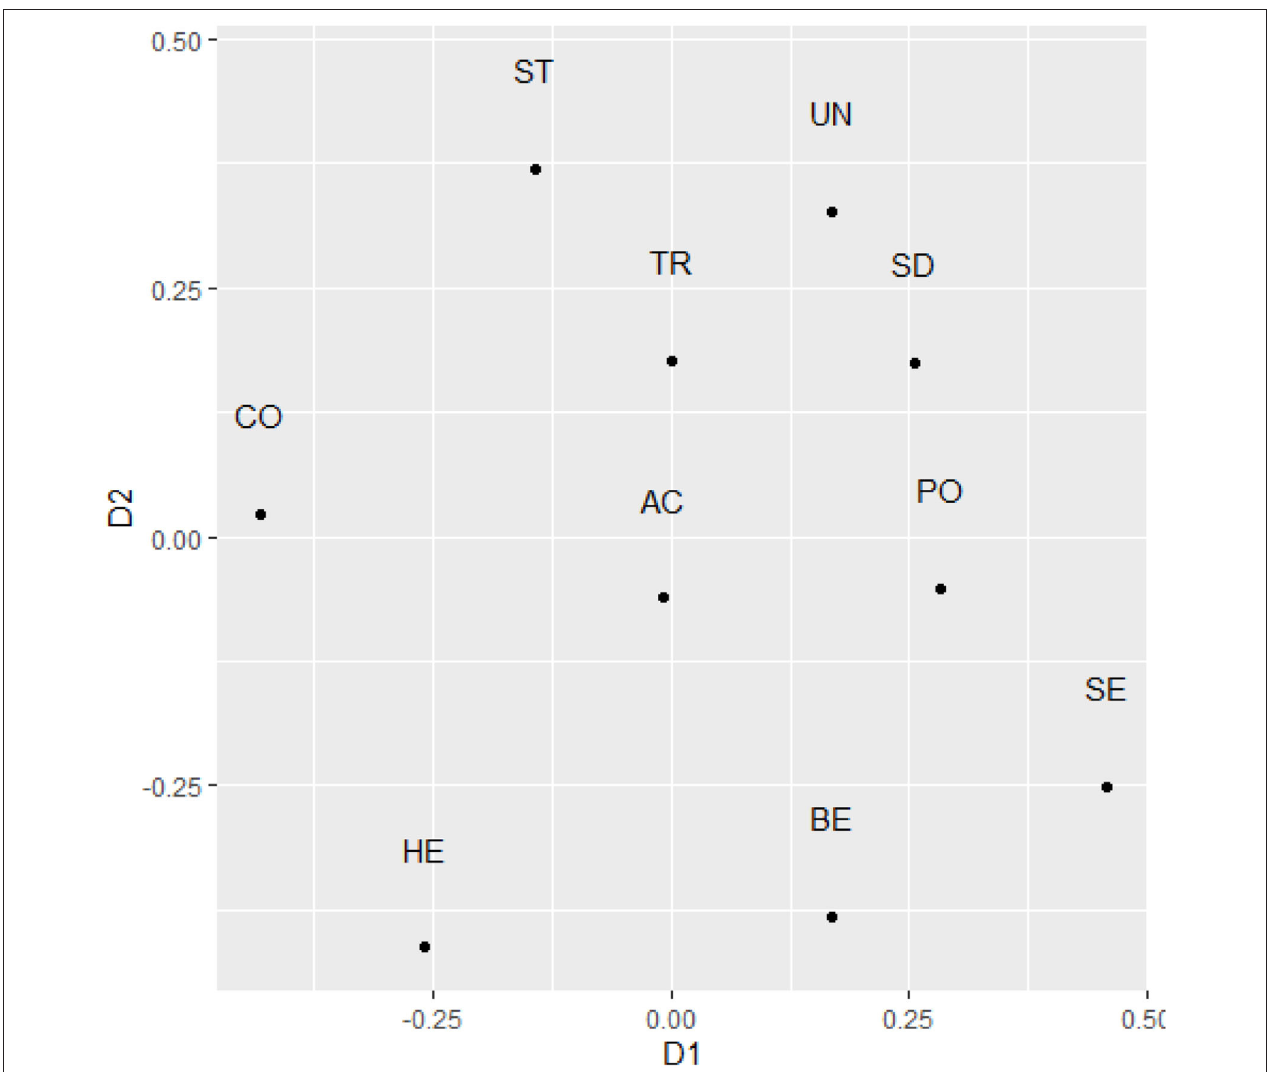
FIGURE 4 | The two-dimensional representation of raw text-based value scores after rotation to maximal similarity with theoretical predictions in Study 3. SD, Self direction; ST, Stimulation; HE, Hedonism; AC, Achievement; PO, Power; SE, Security; TR, Tradition; CO, Conformity; BE, Benevolence; UN, Universalism.